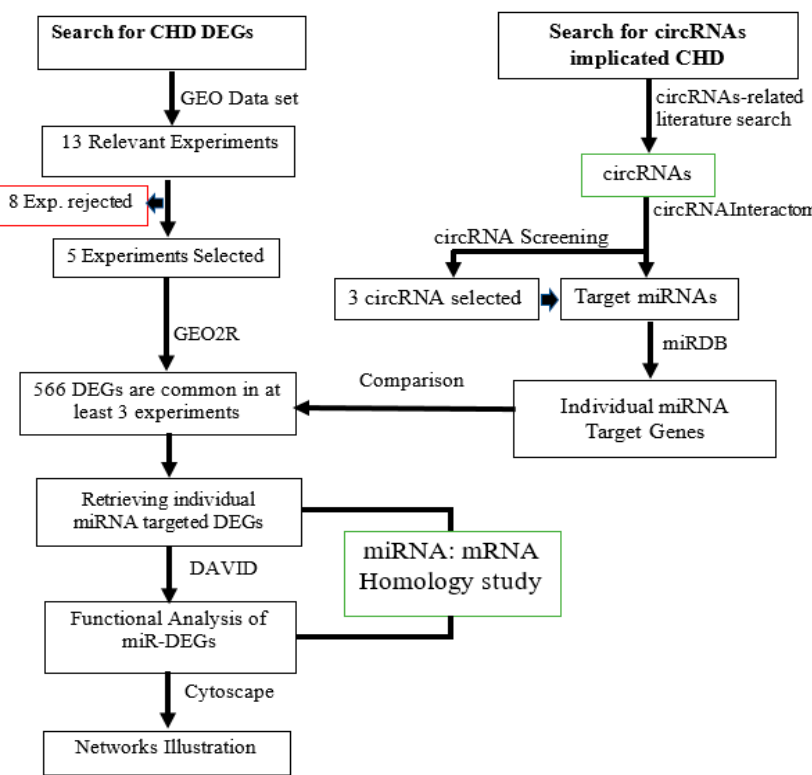
Figure 1. Summary of the workflow used in this study. GEO: gene expression omnibus, CHD: coronary heart disease, DEG: differentially expressed genes, miR-DEGs: differentially expressed miRNA target genes, circRNAs: circular RNAs, miRDB: microRNA database, miRNA: microRNA, DAVID: database for annotation, visualization, and integrated